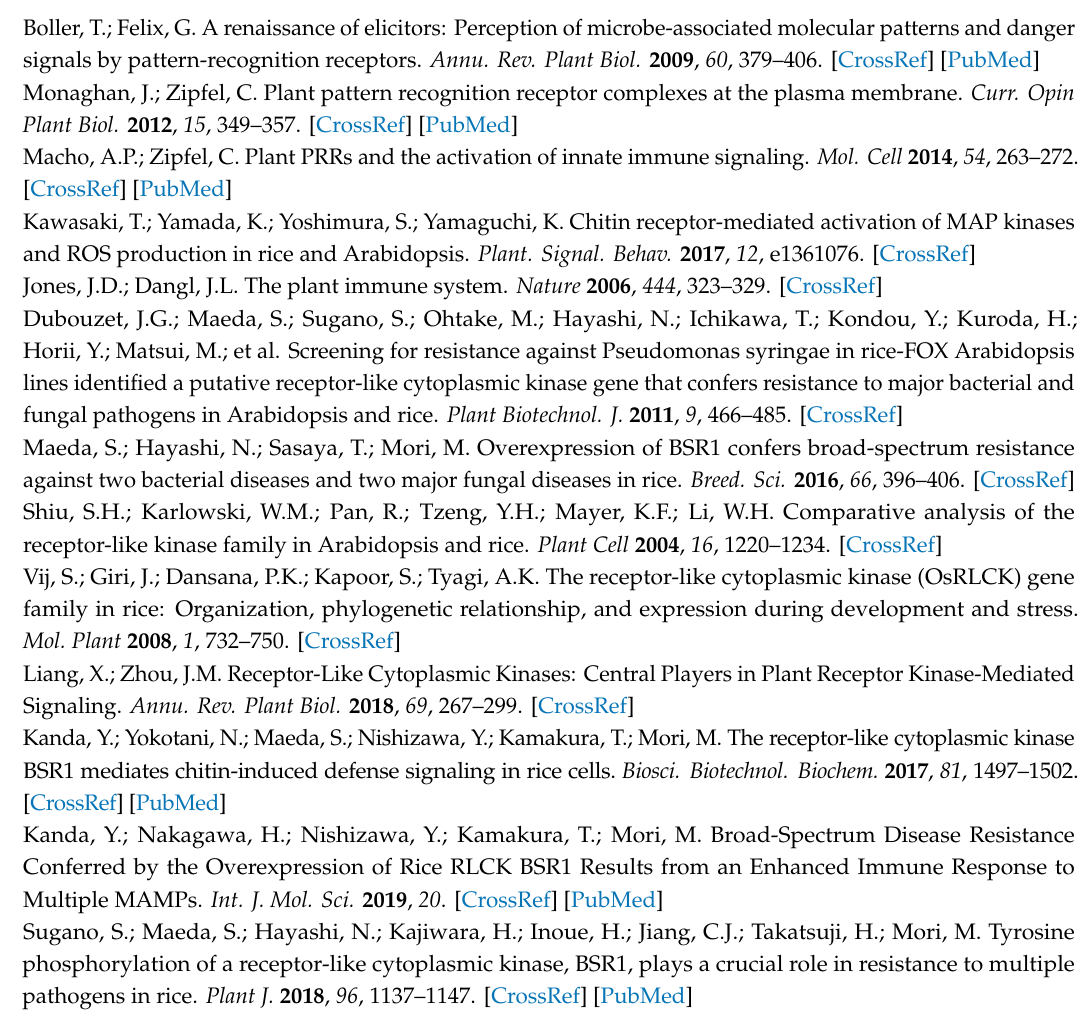
Supplementary Materials: Supplementary materials can be found at http: // www.mdpi.com / 1422-0067 / 21 / 15 / 5397 / s1. Figure S1: Schematic structure of the translation products of wild-type OsCERK1 and mutated OsCERK1 ; Figure S2: Sequences of OsCERK1 transcript in WT, OsCERK1 ko: BSR1 ox lines, and BSR1 ox6; Figure S3: Knockout of OsCERK1 suppressed peptidoglycan-triggered H 2 O 2 production in the BSR1 -overexpressing background; Figure S4: The enhancement of disease resistance by BSR1 overexpression depends on